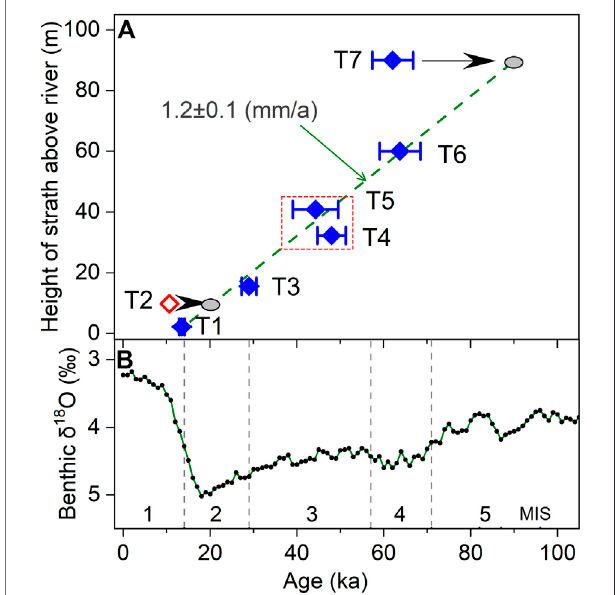
FIGURE 9 | (A) Plot of terrace heights above modern river against terraceages.Theslopeoftheregressionlinerepresentsthelong-termincision rate derived from the T1, T3, T5, and T6 terraces. The measured ages of the T2 and T7 were underestimated, the true ages may be inferred from the regression line. The T4 and T5 terrace may be the same terrace. The open diamond refers to loess samples. (B) The oxygen isotope curve for comparison to terrace ages, MIS refers to the marine oxygen isotope stages (Lisecki and Raymo,